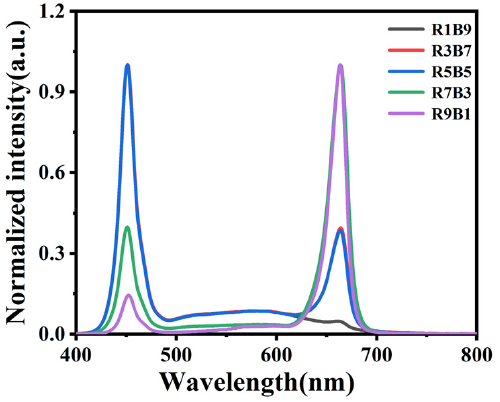
Figure 1. Spectral distribution of